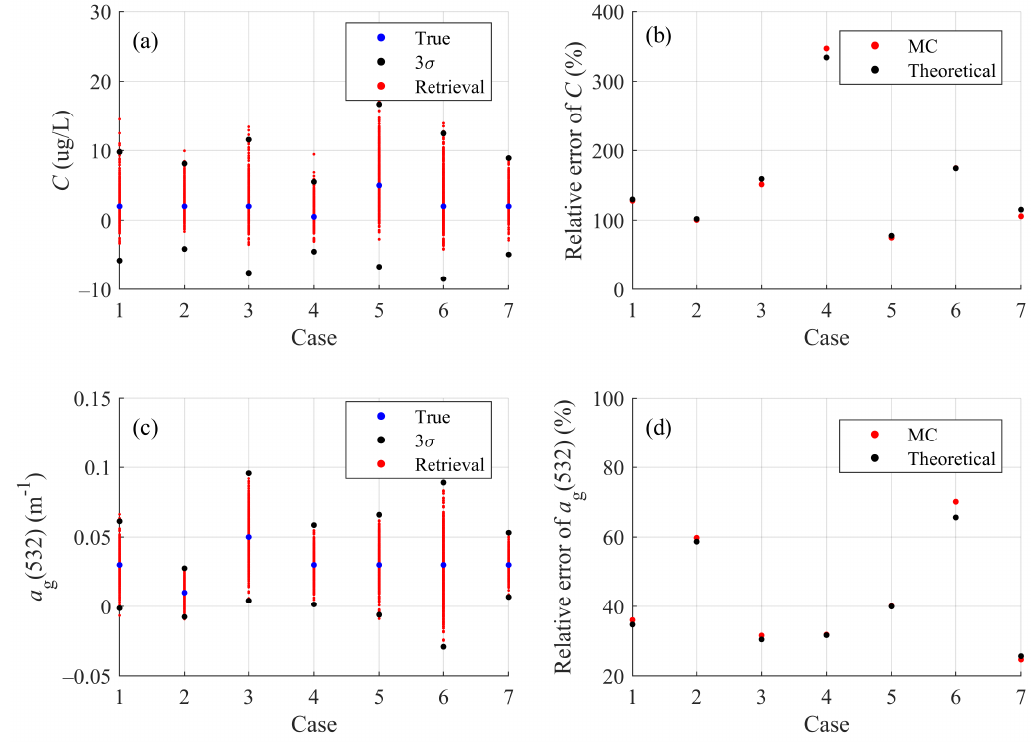
Figure 2. C and a g (532) retrieved by the theoretical model and Monte Carlo (MC) method under 7 cases in Table 1. ( a ) C ; ( b ) relative error of C ; ( c ) a g (532); ( d ) relative error of a g